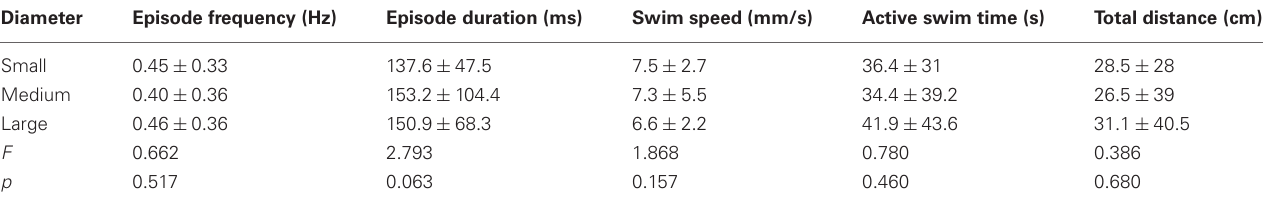
Table 3 | Comparison of the properties of locomotor activity for larvae in behavioral wells of different diameters. Diameter